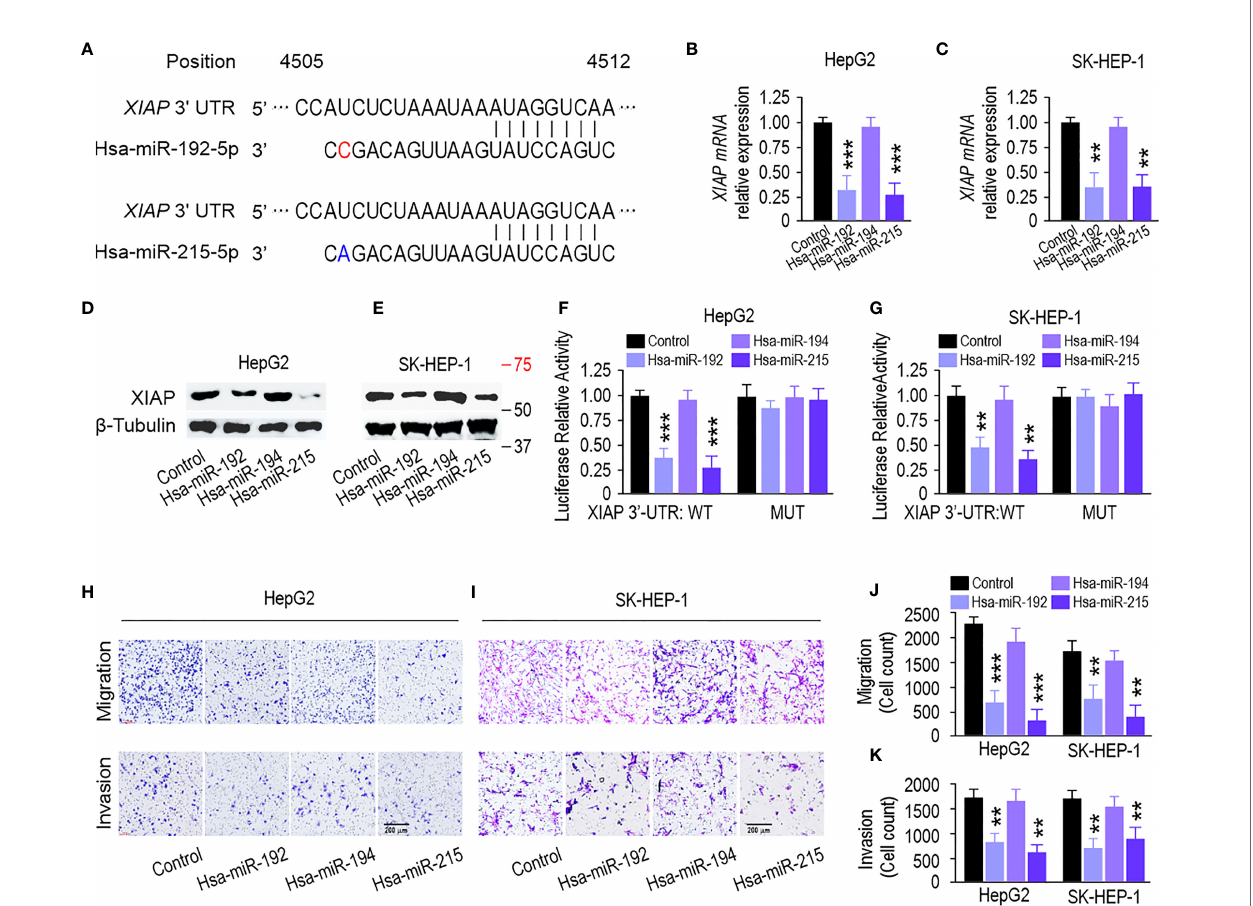
FIGURE 5 | miR-192 family inhibits liver cancer progression through targeting XIAP. (A) Predicted miR-192s binding sites in XIAP 3 ’ -UTR by bioinformatics analysis. (B, C) miR-192s decreased the mRNA level and protein expression (D, E) of XIAP in HepG2 and SK-HEP-1 cells. (F, G) Luciferase reporter activity con fi rmed the interaction between miR-192s and XIAP in HepG2 and SK-HEP-1 cells. (H, I) Migration and invasion capabilities evaluated by transwell assays in HepG2 and SK- HEP-1 cells transfected with miR-192s mimics. (J, K) Colorimetric measurement of panels (H, I) . (*p < 0.05, **p < 0.01, ***P <